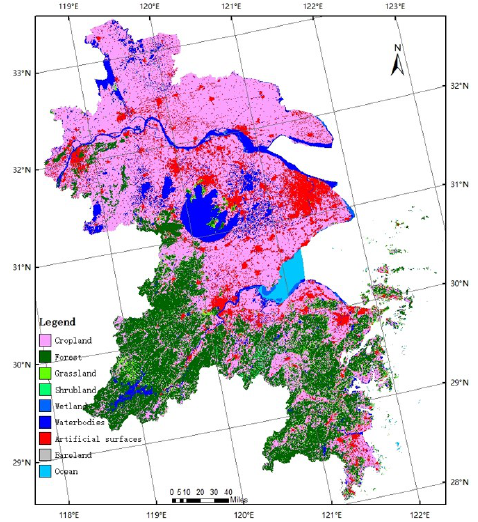
Figure 3 . GlobLand30-2010a of the Yangtze River Delta urban agglomeration.